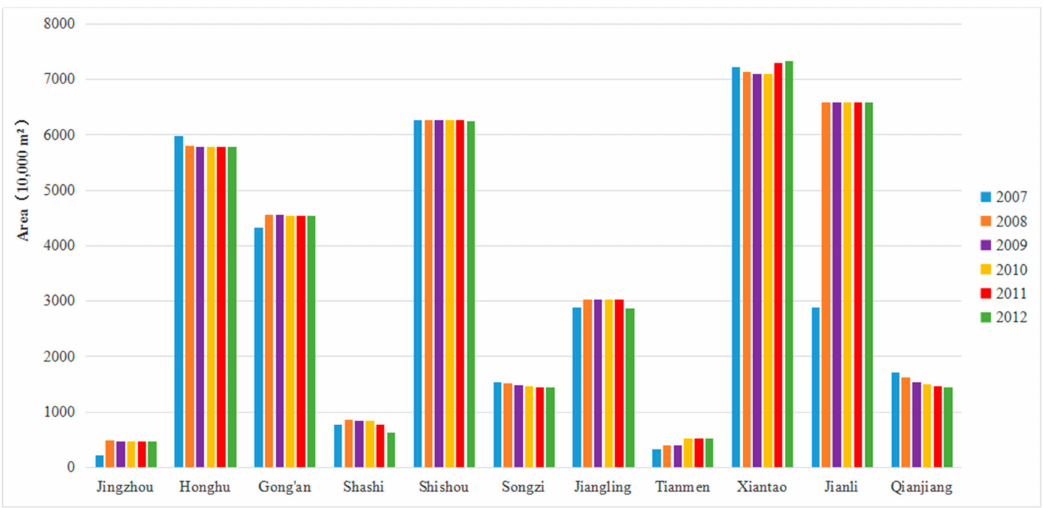
Figure 2. Gross O. hupensis snail habitat area.